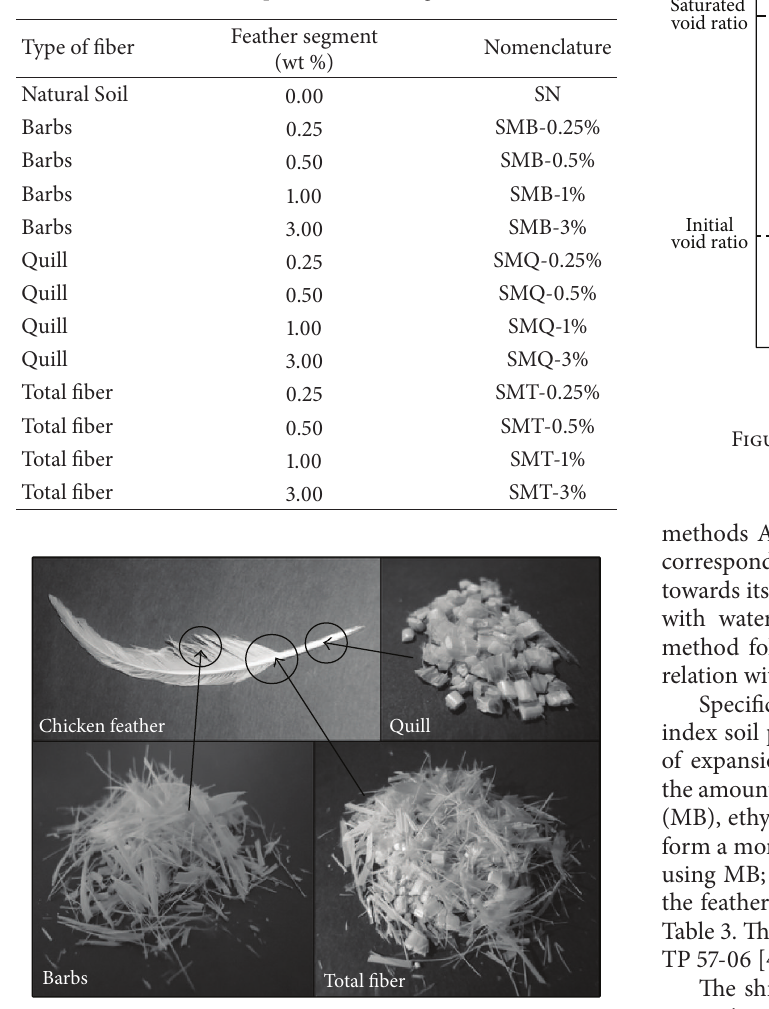
Table 3: Nomenclature adopted for feather segments-soil mixtures.